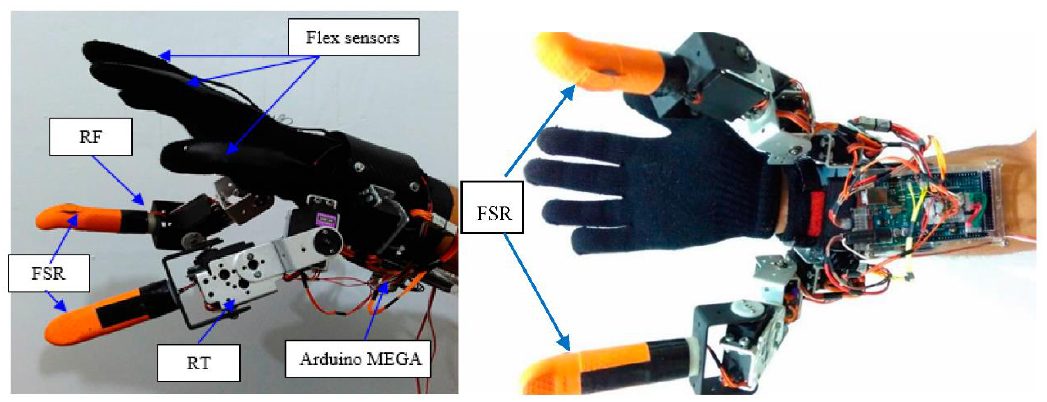
Figure 2. Developed extra robotic fingers for assisting bimanual task.